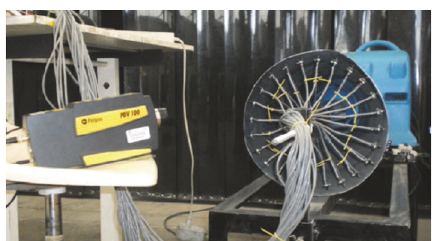
Figure 2: Experimental setup and laser vibrometer used for calibra-